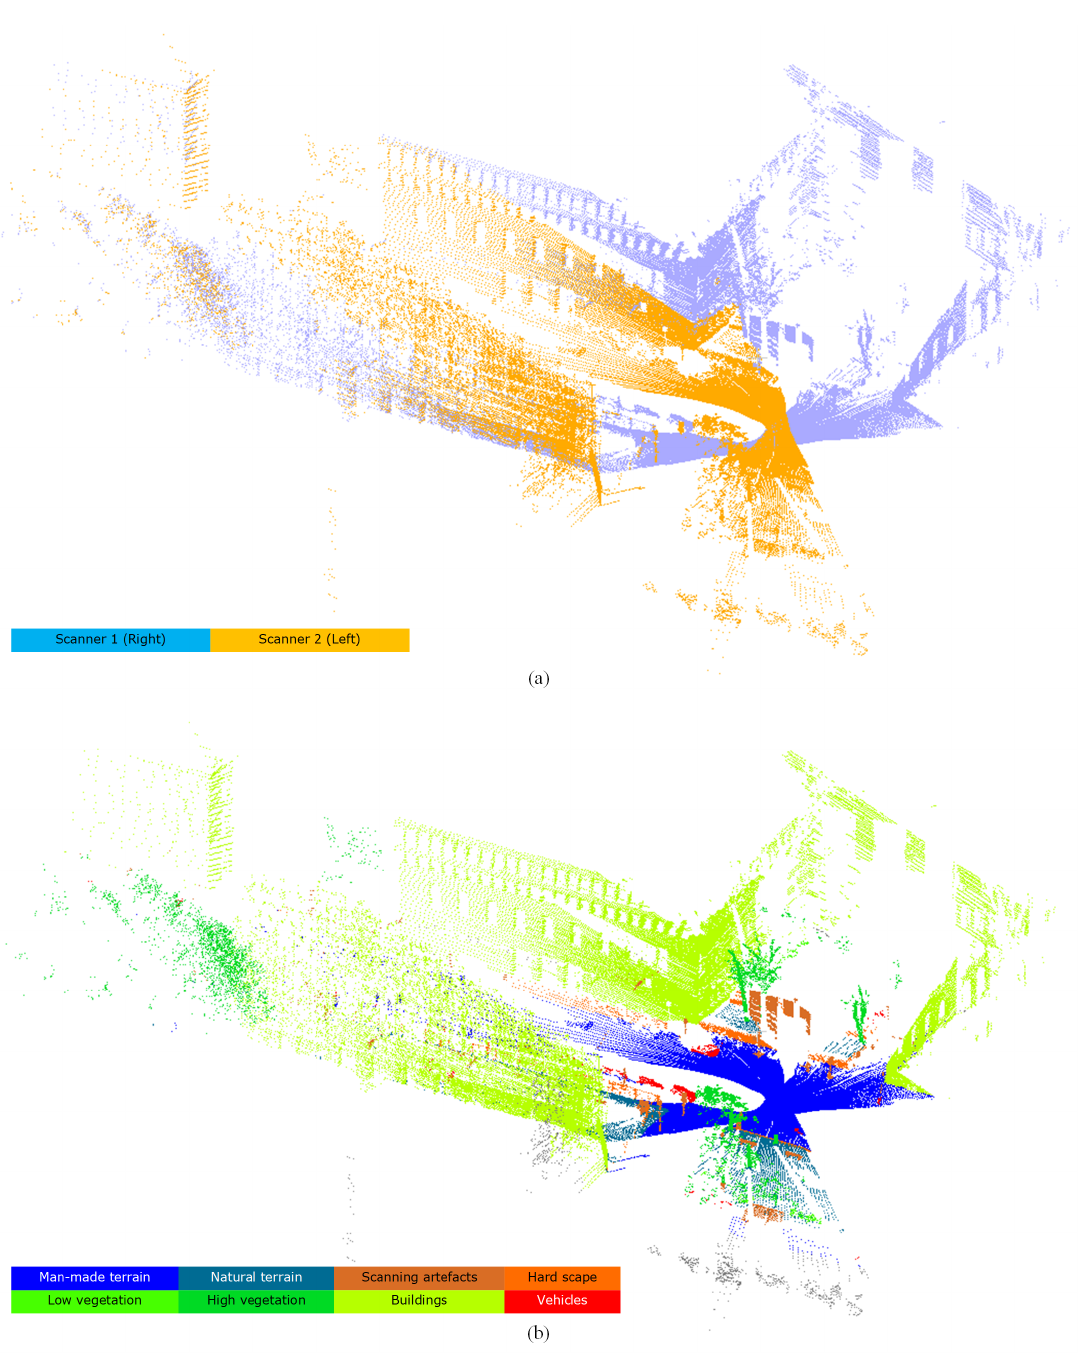
Figure 10. The annotated single 360 ◦ laser scans. ( a ) Points of two 360 ◦ scans from different scanners (i.e., left and right ones) at the same time of data acquisition. ( b ) Annotated points of two 360 ◦ scans at the same time of data